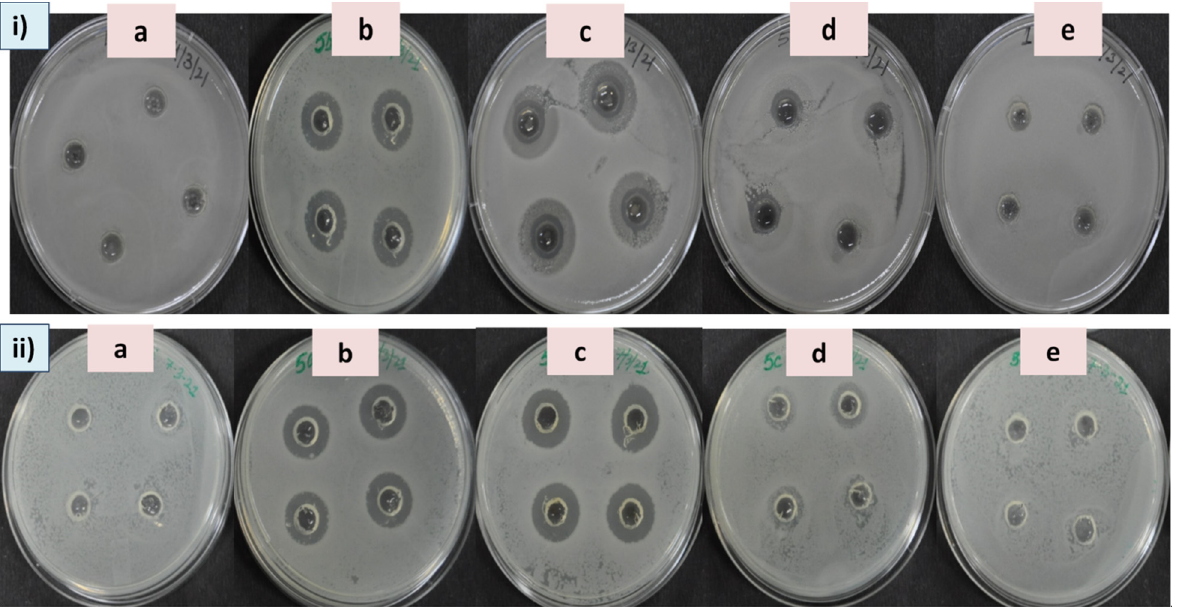
Figure 5. Zone of inhibition after 24 h of incubation at 500 ppm in ( i ) B. subtilis : (a) media control, (b) SN, (c) ELAgNPs, (d) CAgNPs, and (e) ELExt; and ( ii ) in E. coli : (a) media control, (b) SN, (c) ELAgNPs, (d) CAgNPs, and (e) ELExt.